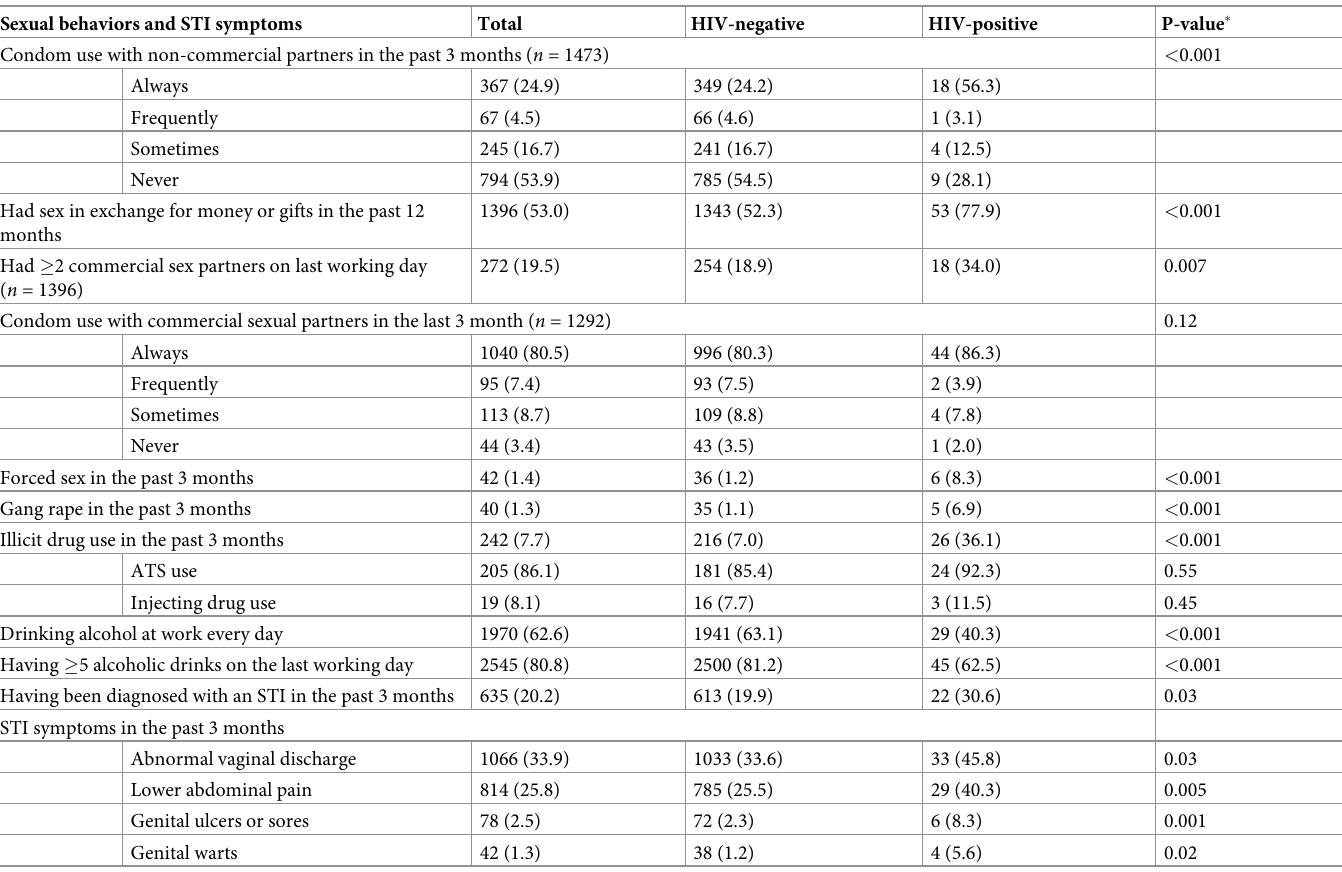
Table 2. HIV risks among HIV-positive and HIV-negative FEWs in the study ( n =